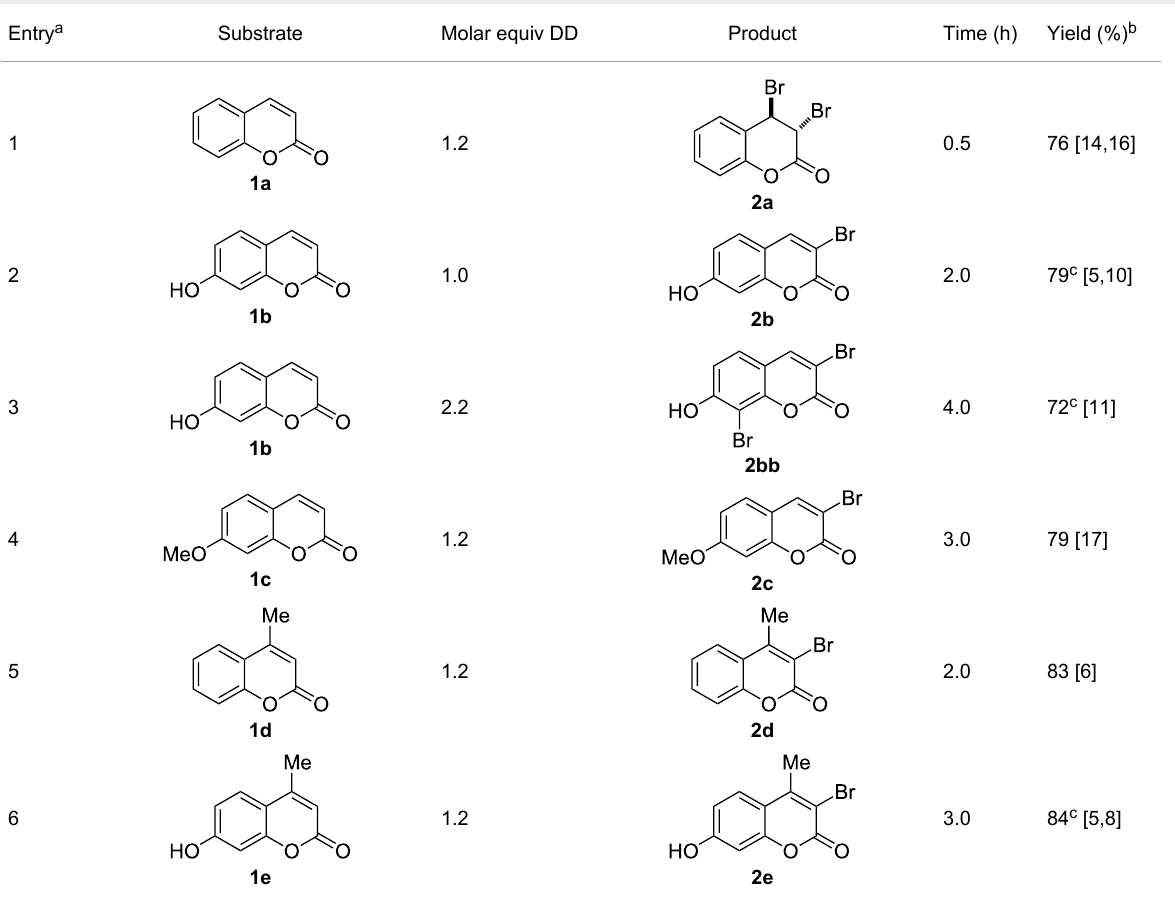
Table 1: Solvent-free reactions of substituted coumarins with dioxane